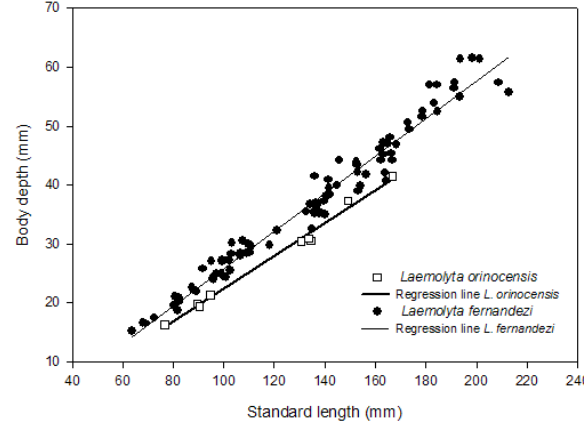
Fig. 17. Regression lines of body depth on standard length for specimens of Laemolyta orinocensis and L. fernandezi .